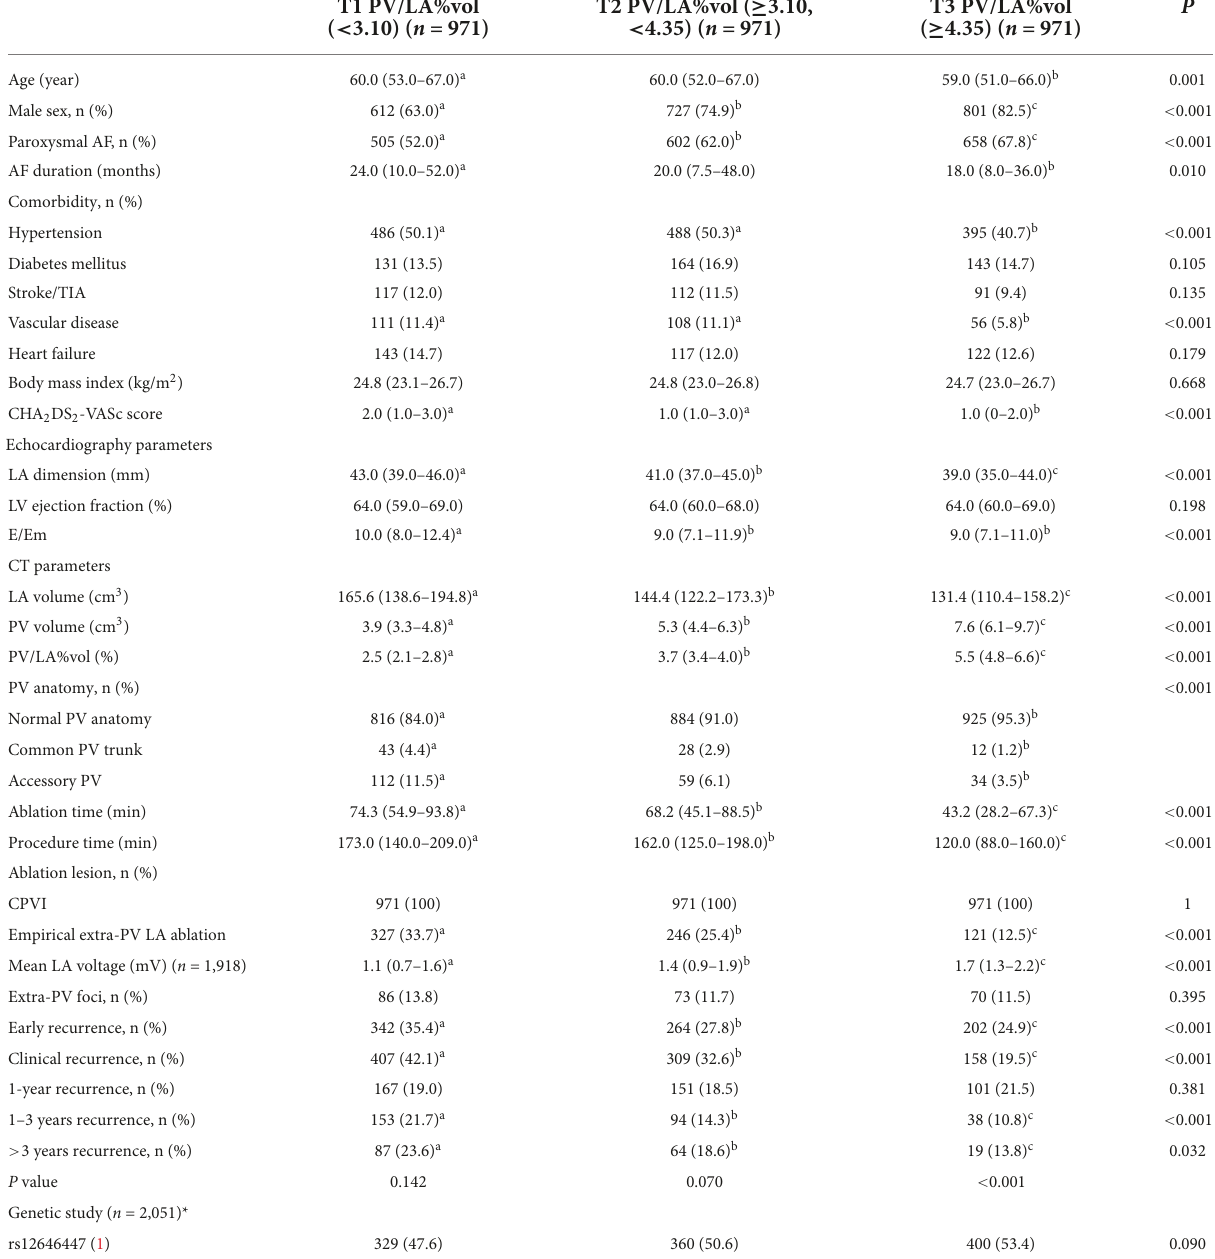
TABLE 2 Clinical and procedural characteristics among the three groups according to PV/LA%vol